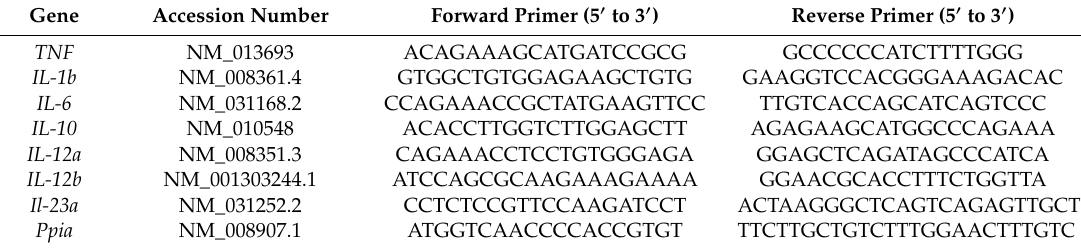
Table 1. Quantitative real-time PCR (qPCR) primers used in this study.